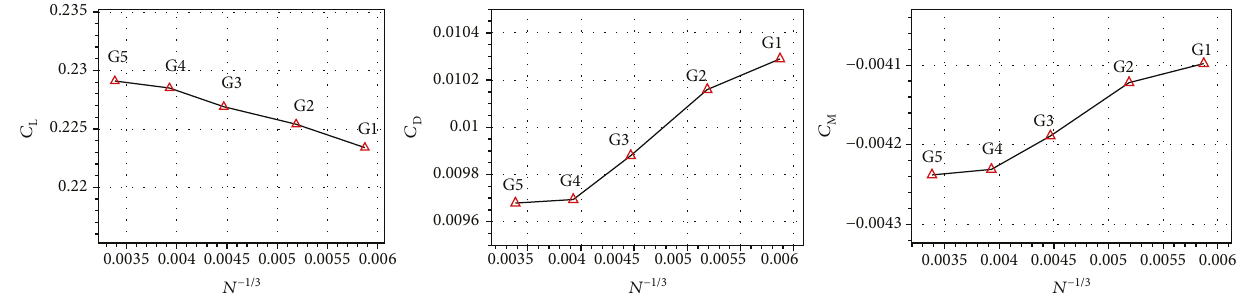
Figure 7: Aerodynamic forces for the powered con fi gurations of the fi ve levels of grids at 1.5 ° (high speed).